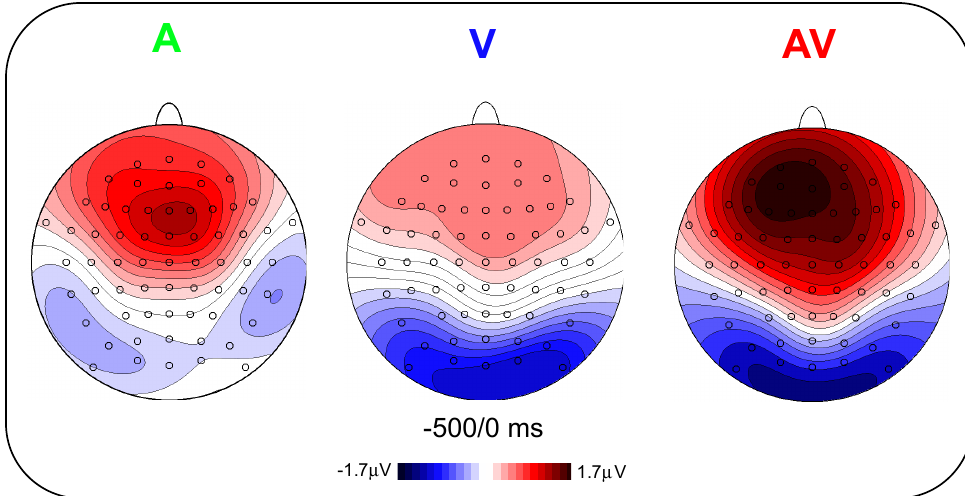
Figure 3. Topographic distribution of the average activity of pre-stimulus ERPs from − 500 to 0 ms in the three experimental conditions.